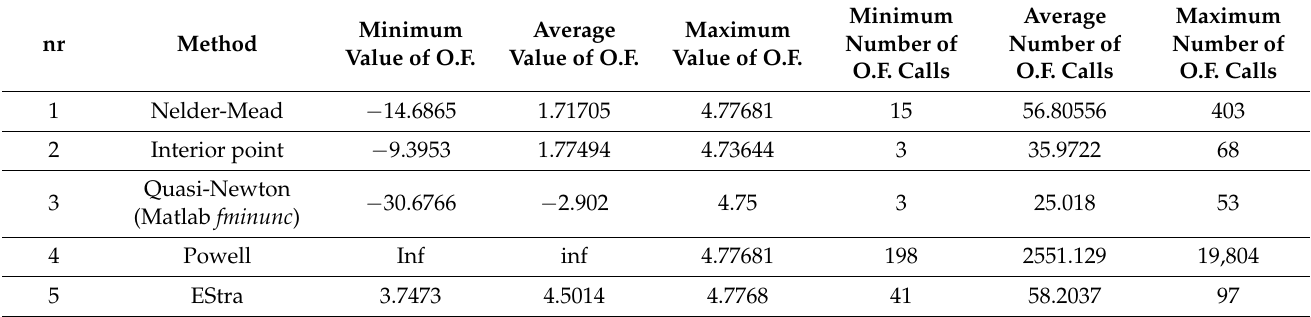
Table 2. Performance of the optimization in the case of Gain maximization (108 starting